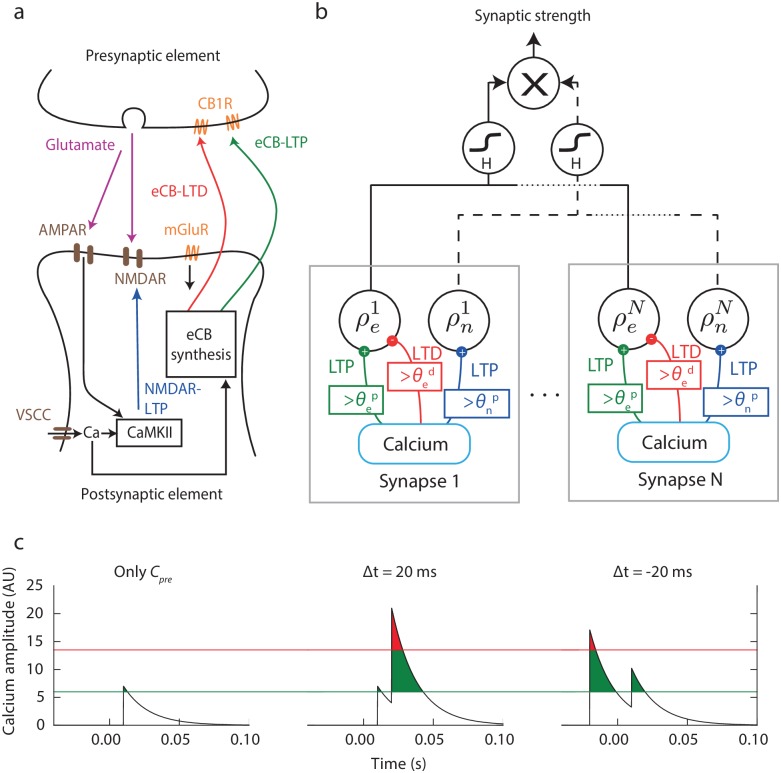
Model for the cortico-striatal STDP.(a) Schematic representation of the cortico-striatal synapse: three independent mechanisms of plasticity can be induced in response to calcium influx: eCB-LTD, eCB-LTP and NMDAR-LTP. The dynamics of the NMDAR pathway rely on released glutamate activating NMDAR and AMPA receptors (AMPAR), ultimately acting on calcium-cadmodulin voltage-sensitive calcium channels (VSCC). The eCB synthesis is under the control of metabotropic glutamate receptors (mGluR) and calcium concentration, and acts retrogradely on CB1 receptors (CB1R) on the presynaptic element. (b) Block diagrams of the reduced calcium-based model proposed where each block corresponds to a different individual synapse whose efficiency splits into individual efficacy of NMDAR and eCB pathways. The proportion of synapses changing states are then computed and the sigmoid function H is then applied. The macroscopic change is the product of the contribution of each individual pathway. (c) Calcium spikes and plasticity thresholds for different STDP protocols (see parameters in Table 1, thresholds are those associated with the eCB pathway, red for LTD and green for LTP).